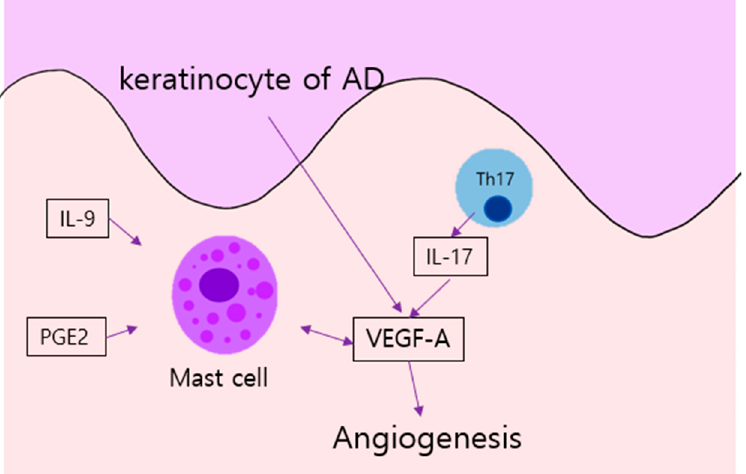
Figure 2. Angiogenesis in AD: Keratinocyte of AD produce VEGF. In addition, mast cells of AD, stimulated by IL-9 and PGE2, provoke angiogenesis through VEGF-A; such expression is also simulated by IL-17 from Th 17 cells. AD, atopic dermatitis; IL, interleukin, PGE2, prostaglandin E2; Th, T helper cell; VEGF, vascular endothelial growth factor.